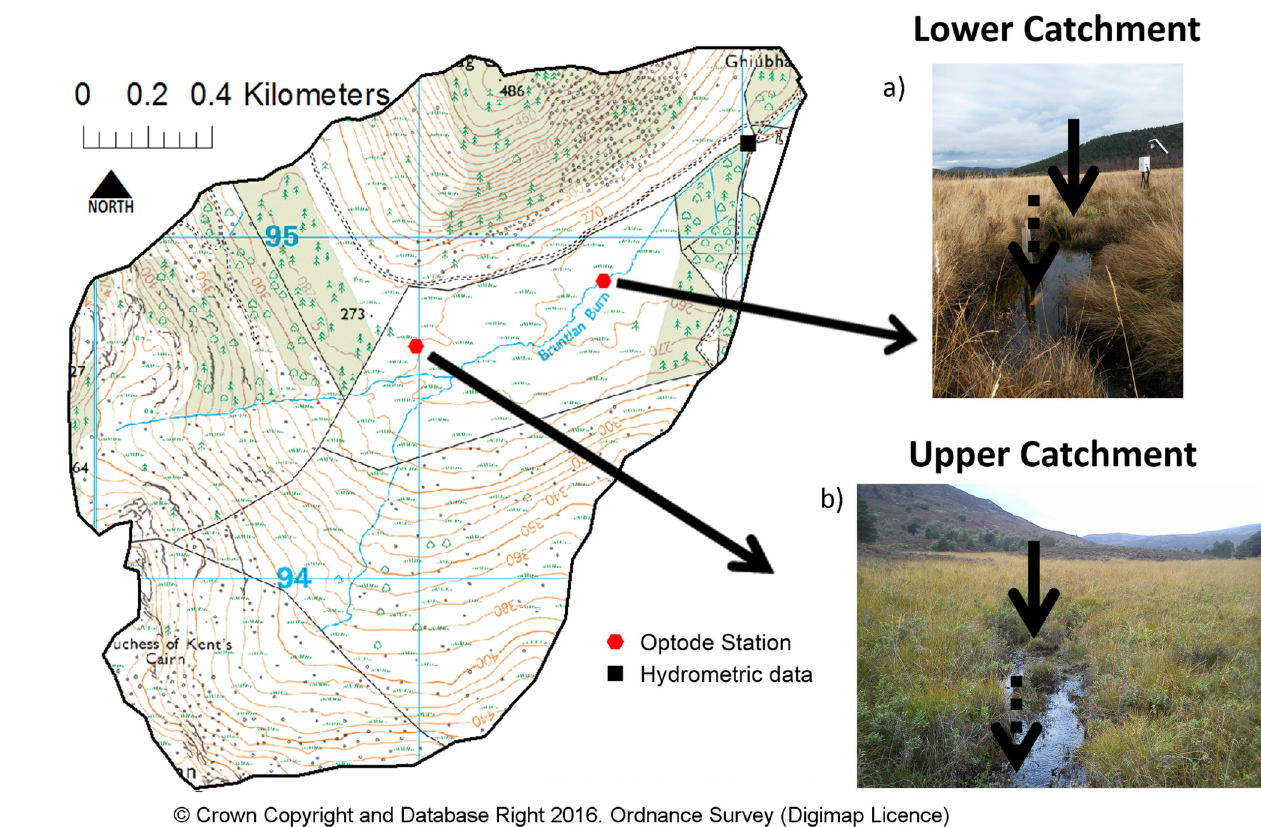
Fig 1. Topography of the study catchment and location of hydrometric data (black square) and optode dissolved oxygen measurement locations (red hexagon). a) photograph of lower catchment location b) photograph of upper catchment location. Arrows on the photographs show the approximate location of optodes. Dashed arrow = upstream. Solid arrow =